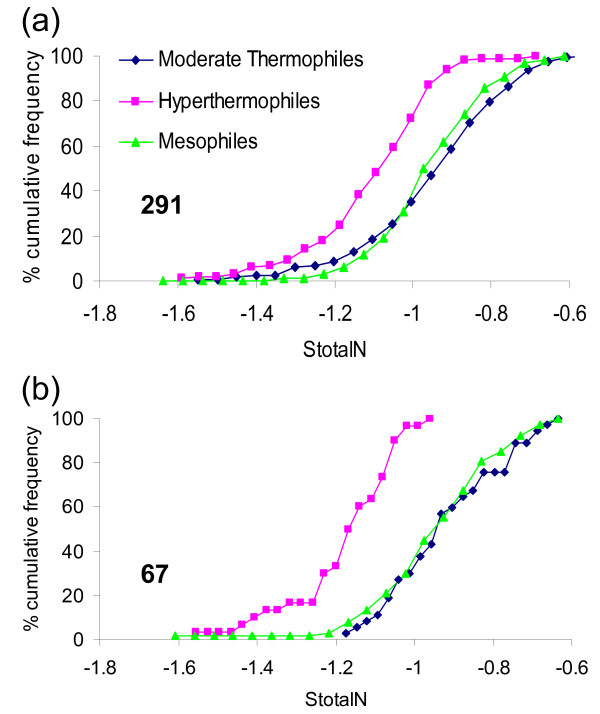
Separation by StotalN. Cumulative frequency distributions of StotalN. (a) The 291 set. (b) The 67 subset.